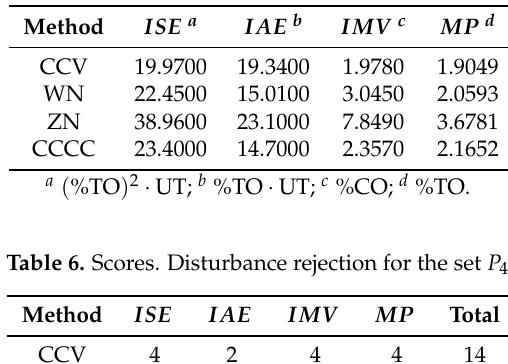
Table 5. Performance indexes. Disturbance rejection for the set P 4 .